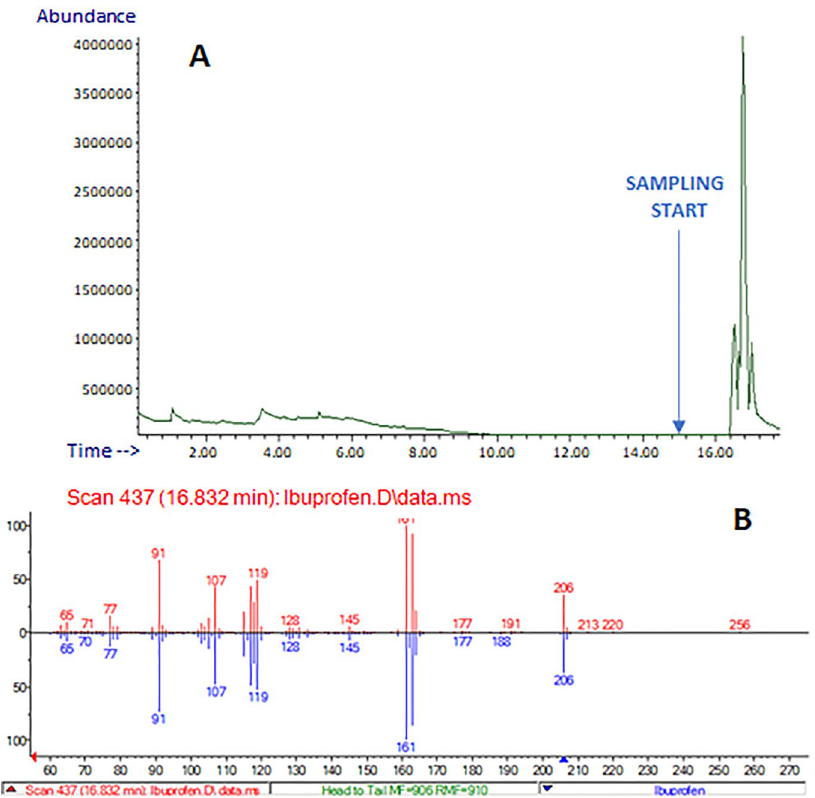
Figure 3. ( A ) Analysis of a Brufen tablet: TIC; ( B ) NIST library spectrum matching: red, experimental spectrum; blue, library spectrum. The arrow indicates the sampling